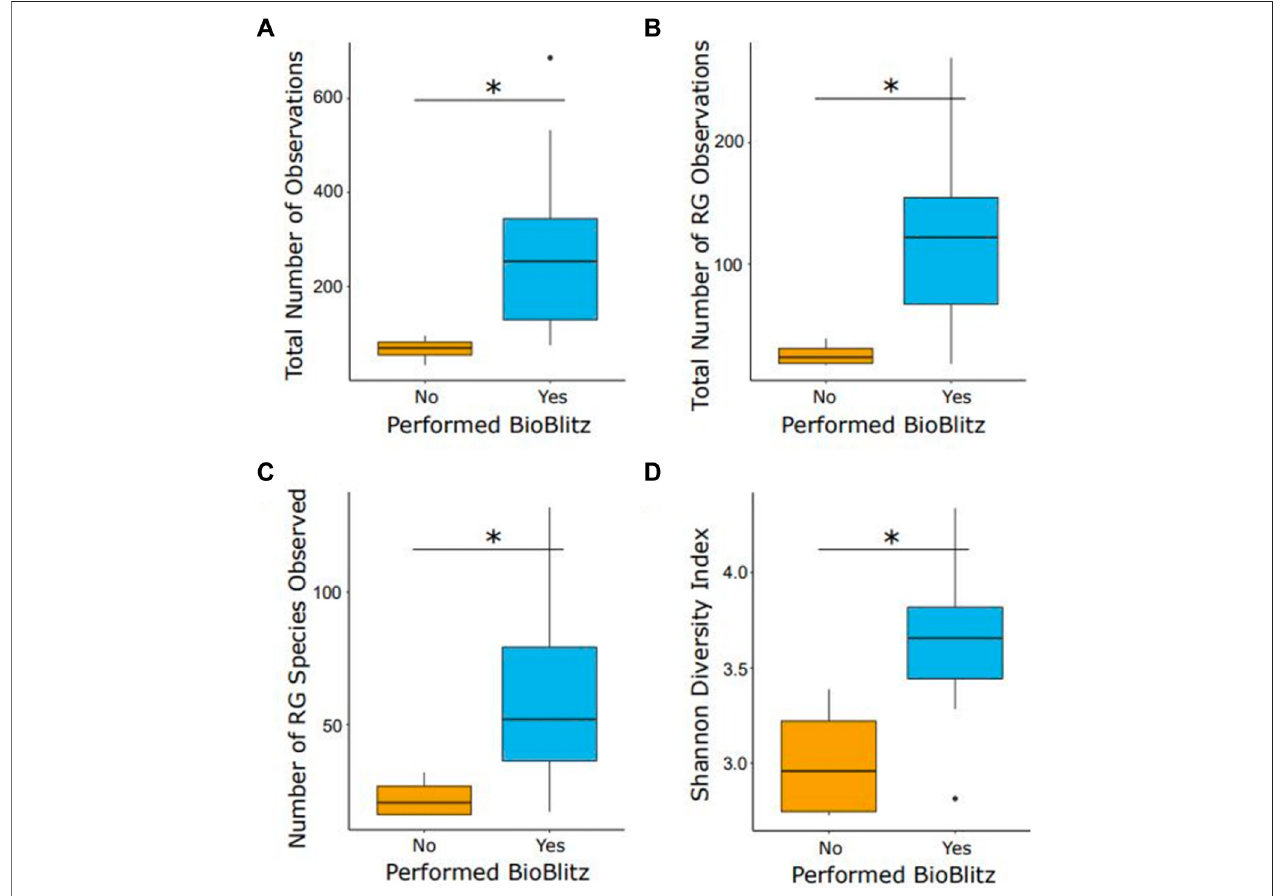
FIGURE6| EffectofBioBlitzonamountofdataanddiversityrecorded.Boxplotsshowingthe (A) totalnumberofobservations, (B) numberofResearchGrade(RG) observations, (C) number of RG species detected, and (D) Shannon diversity index for sites that did or did not perform a BioBlitz are shown. Performing a BioBlitz increased the Shannon diversity recorded at sites. Signi fi cant differences are shown with an * representing p < 0.05.